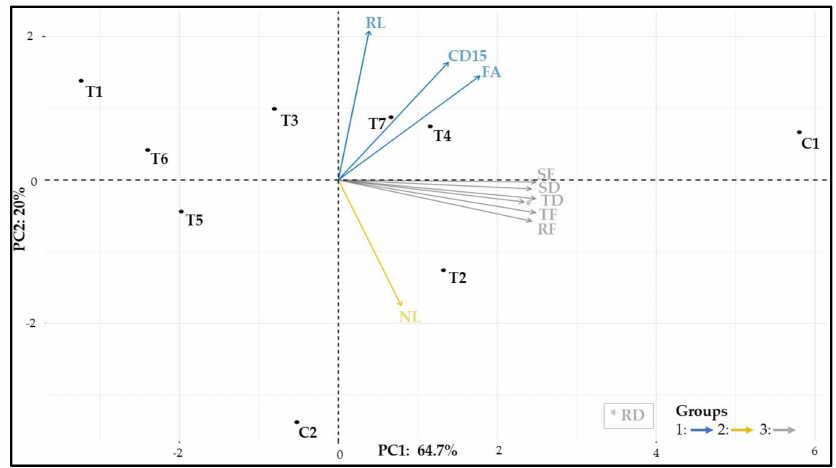
Figure 11. Principal component analysis with the morphoanatomical variables. CD15: crown diameter (Day 15), FA: leaf area, NL: number of leaves, RL: root length, SF: shoot fresh weight, SD: shoot dry weight, RF: root fresh weight, RD: root dry weight, TF: total fresh weight, TD: total